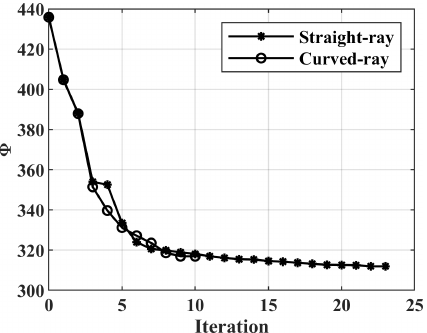
Figure 9. The misfit function values at different iterations of SWT inversions.